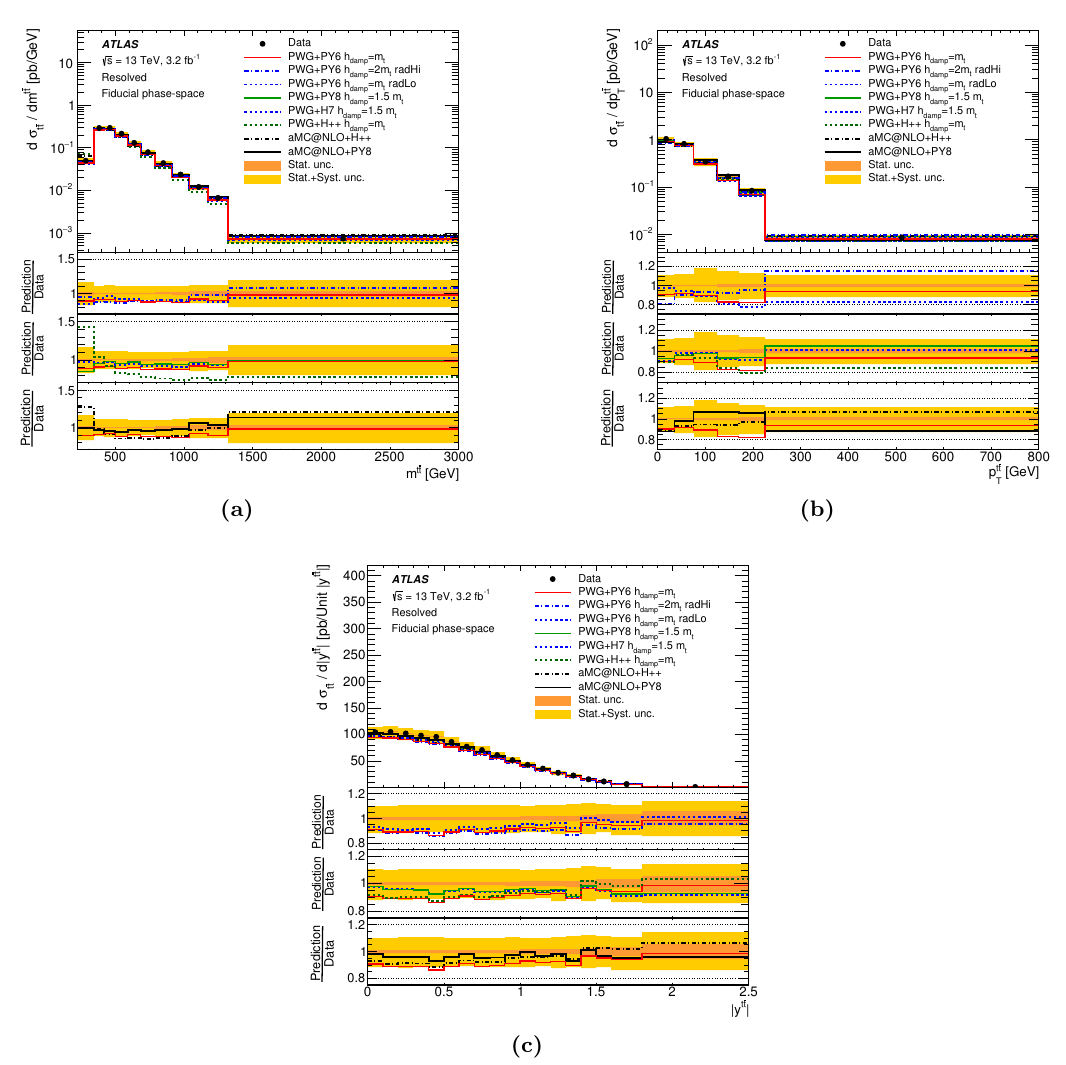
Figure 16. Fiducial phase-space absolute di(cid:11)erential cross-sections as a function of the (a) invariant (cid:12) (cid:22) t (cid:12) mass ( m t (cid:22) t ), (b) transverse momentum ( p t (cid:22) t ) and (c) the absolute value of the rapidity ( (cid:12) y t (cid:12) ) of the t (cid:22) t T system in the resolved topology. The yellow bands indicate the total uncertainty of the data in each bin. The Powheg + Pythia6 generator with h damp = m t and the CT10 PDF is used as the nominal prediction to correct for detector e(cid:11)ects. The lower three panels show the ratio of the predictions to the data. The (cid:12)rst panel compares the three Powheg + Pythia6 samples with di(cid:11)erent settings for additional radiation, the second panel compares the nominal Powheg + Pythia6 sample with the other Powheg samples and the third panel compares the nominal Powheg + Pythia6 sample with the MadGraph5 a MC@NLO